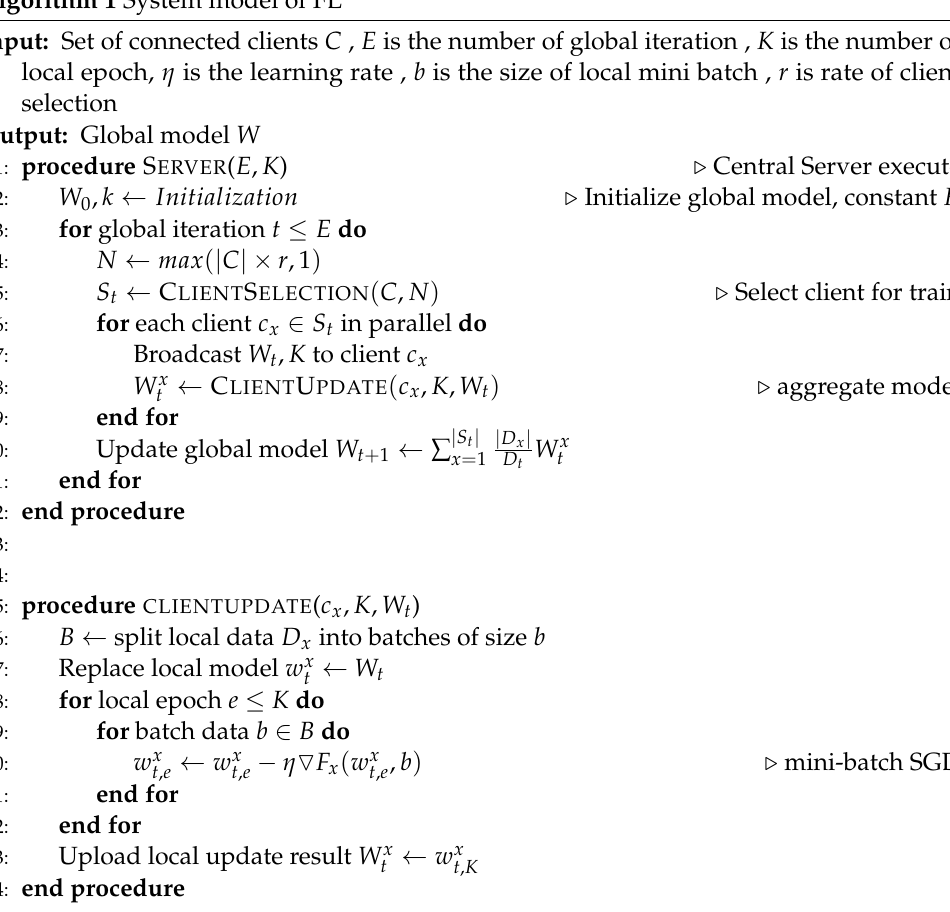
Algorithm 1 System model of